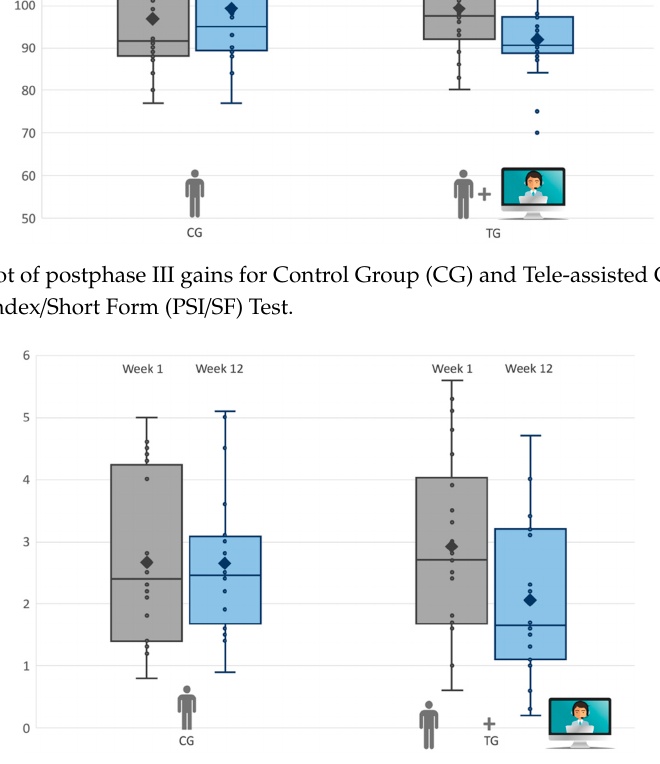
Figure 3. Box-plot of postphase III gains for gains for control group (CG) and tele-assisted group (TG) in the Home Situation Questionnaire-ASD Version (HSQ-ASD) Test. Table 2. Multivariate tests for primary outcome variables. Table 4. Pre- and postphase III comparison of outcome measures for control group (CG) and tele-assisted group (TG)